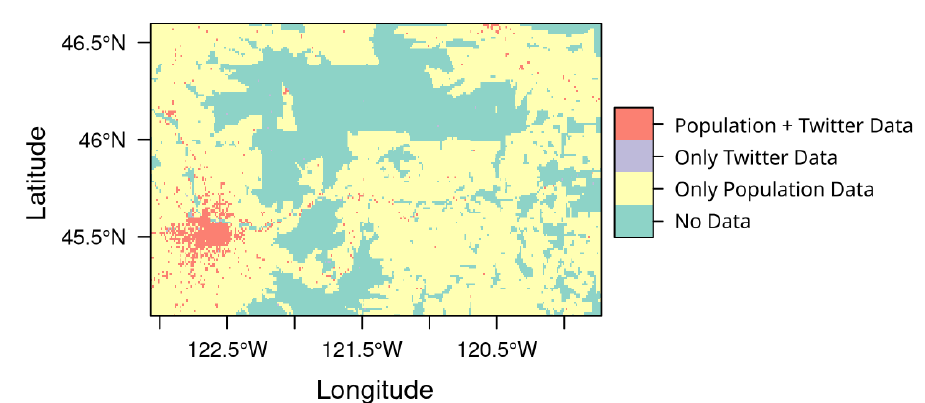
Figure 2. Twitter and Population Data